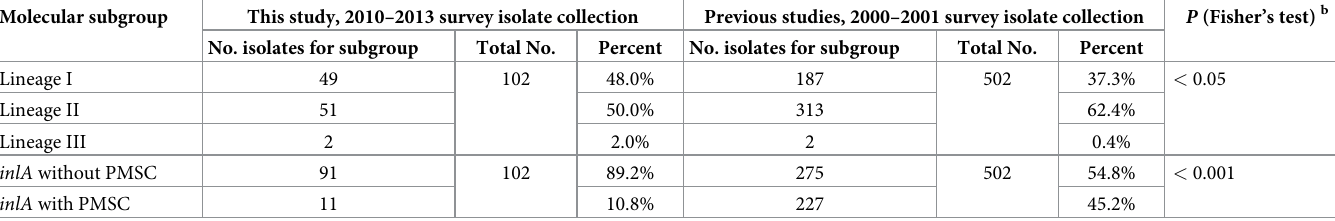
Table 1. Proportion of L . monocytogenes isolates obtained from large-scale market basket surveys: Present study compared with previous study a . Molecular